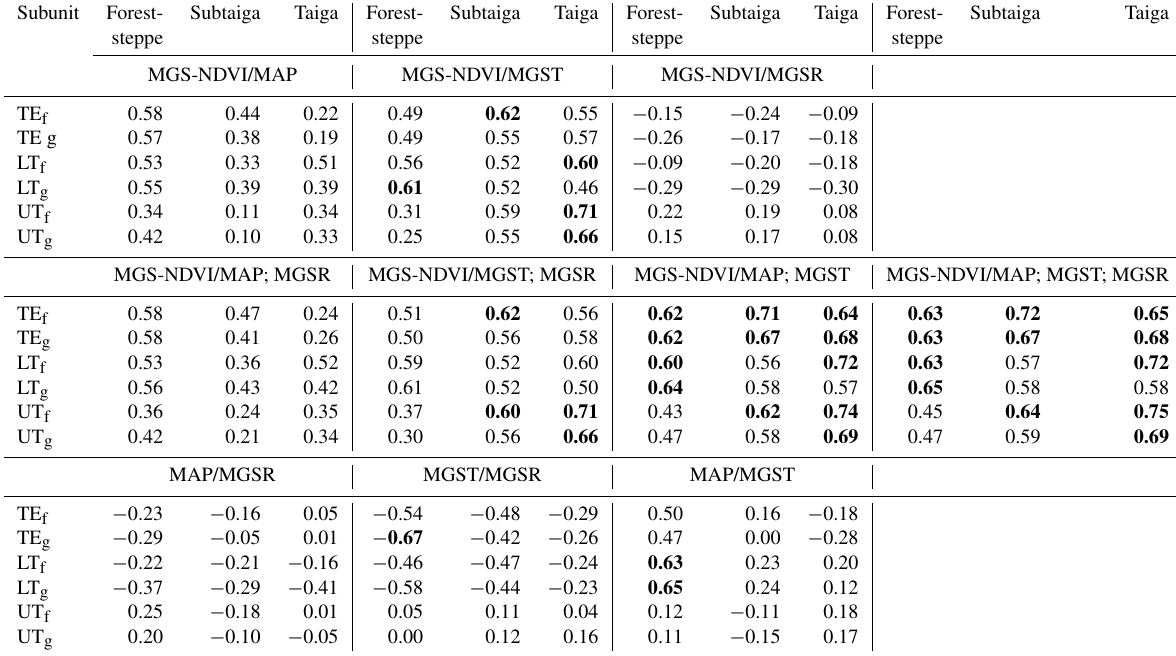
Table 2. Correlation matrix showing Pearson and multiple correlation coefficients ( r ) between NDVI, climate, and terrain parameters for different types of boreal forest and ecological subunits. (MAP: mean annual precipitation, MGST: mean growing season temperature, MGS- NDVI: mean growing season normalized differentiated vegetation index, MGSR: mean growing season solar radiation input; subunits are TE: total ecological unit, LT: lower treeline, UT: upper treeline, s: portion of grassland, f: portion of forest). Bold letters highlight strong correlations between the different parameters.